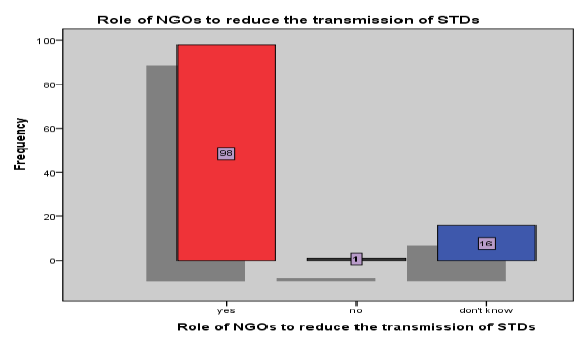
Figure 6: Role of NGO’s to reduce the transmission of STDs among slum